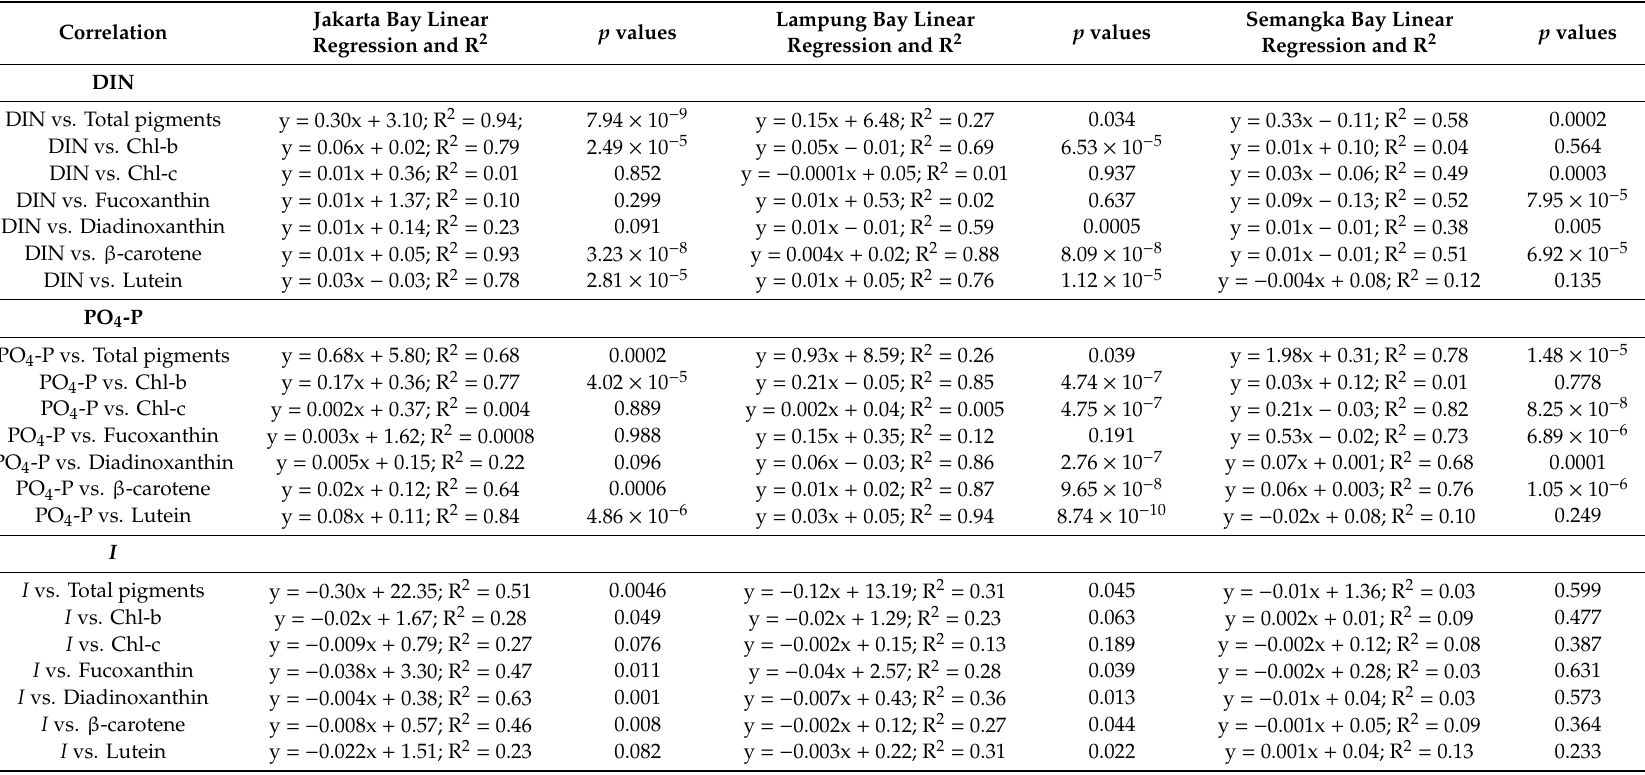
Table 2. Linear regression correlation properties between each nutrient species and underwater light to each algae pigment in each bay.